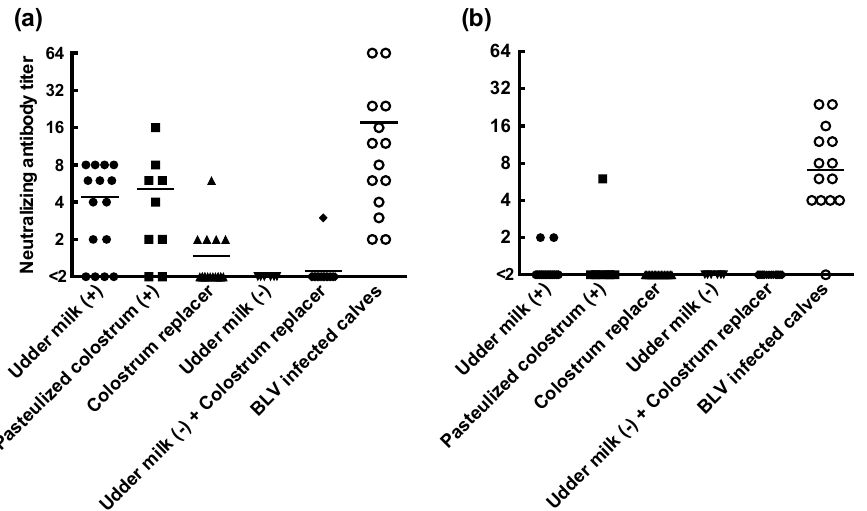
Figure 1. Titers of neutralizing antibodies against BLV in 1- and 4-month-old calves fed with udder milk, pasteurized colostrum and colostrum replacer. The titers of neutralizing antibodies against bovine leukemia virus (BLV) in 1 ( a )- and 4 ( b )-month-old calves were compared between the types of feeding milk. The titers were quantified using the syncytium-induction inhibition assay. The types of feeding milk and the number of sampled calves were as follows: Udder milk (+): udder milk from dams with BLV ( n = 15); Pasteurized colostrum (+): pasteurized colostrum from a nearby farm with BLV ( n = 9); Colostrum replacer: commercial colostrum replacer pasteurized using a drying treatment ( n = 19); Udder milk ( − ): udder milk from dams without BLV ( n = 6), Udder milk ( − ) + colostrum replacer: udder milk ( − ) supplemented with commercial colostrum replacer ( n = 18); BLV-infected calves: 1-month-old calves vertically infected with BLV ( n = 14). Horizontal lines show the median values of the neutralizing antibody titers.